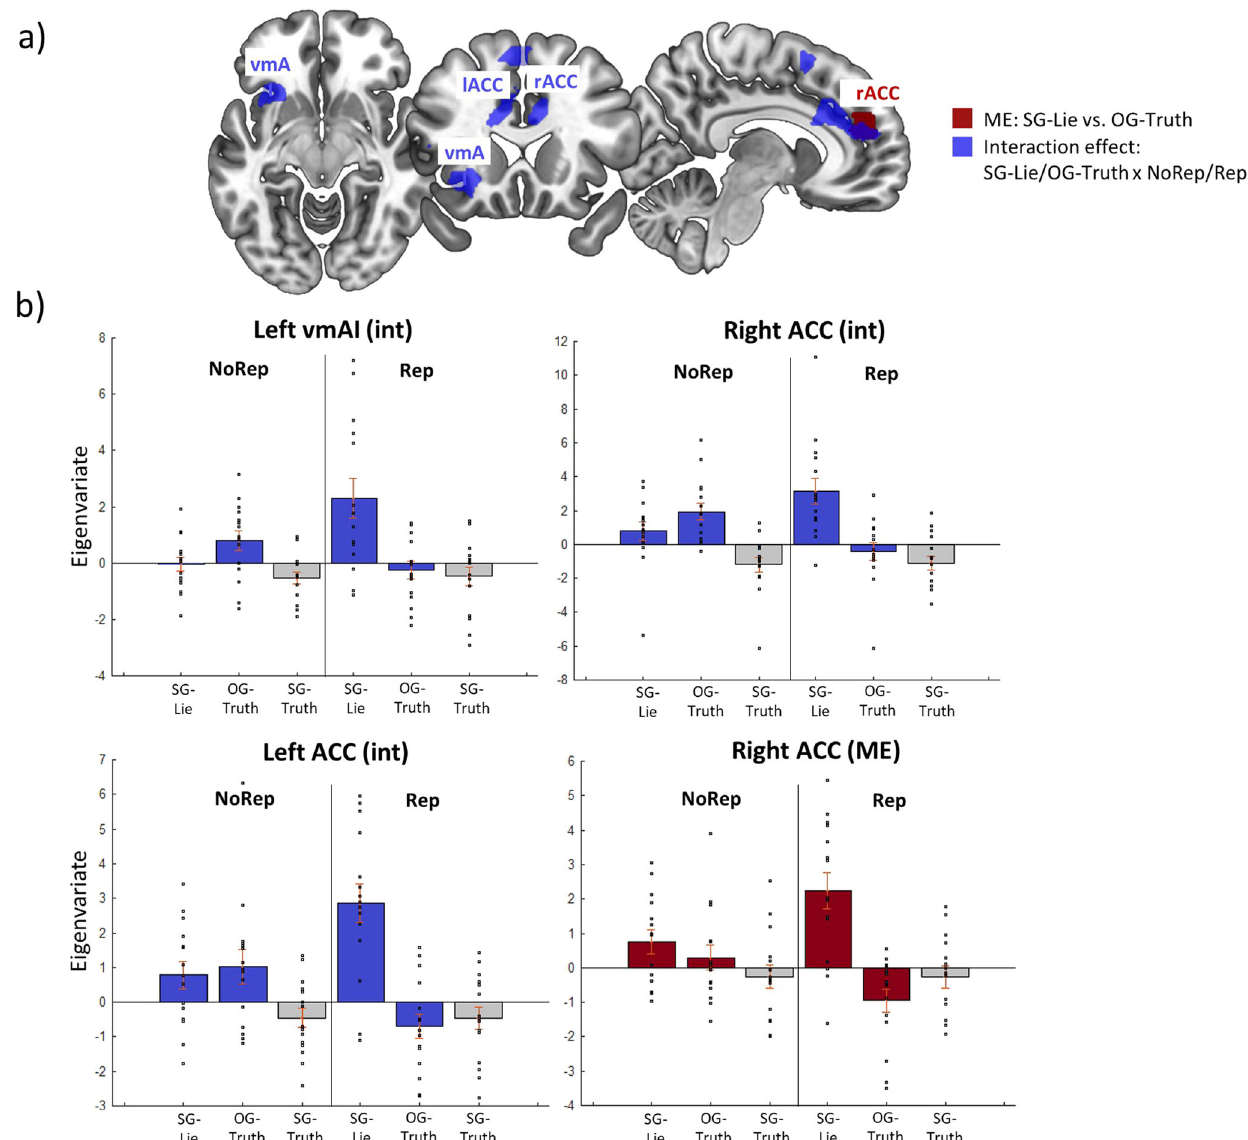
Fig. 3 Brain activation related to self-gain lies compared to other-gain truths and self-gain lies under reputation risk. Results of GLM2: a axial, coronal, and sagittal slices showing, in red, the regions active for self-gain lies vs. other-gain truths irrespective of reputation conditions and, in blue, the regions that are most active for self-gain lies vs. other-gain truths with reputation risk, namely, the left vmAI, and the bilateral ACC (interaction effect: self-gain lies/ other-gain truths × reputation/no reputation) ( N = 15). b Bar plots showing, in blue, the increased activation of the left vmAI and left and right ACC for self- gain lies with reputation risk (bar 4) and, in red, showing increased activation for self-gain lies (bars 1 & 4) vs. other-gain truths (bars 2 & 5) in both reputation conditions ( N = 15). vmAI ventromedial anterior insula, lACC/rACC left/right anterior cingulate cortex, ME main effect, int interaction effect,